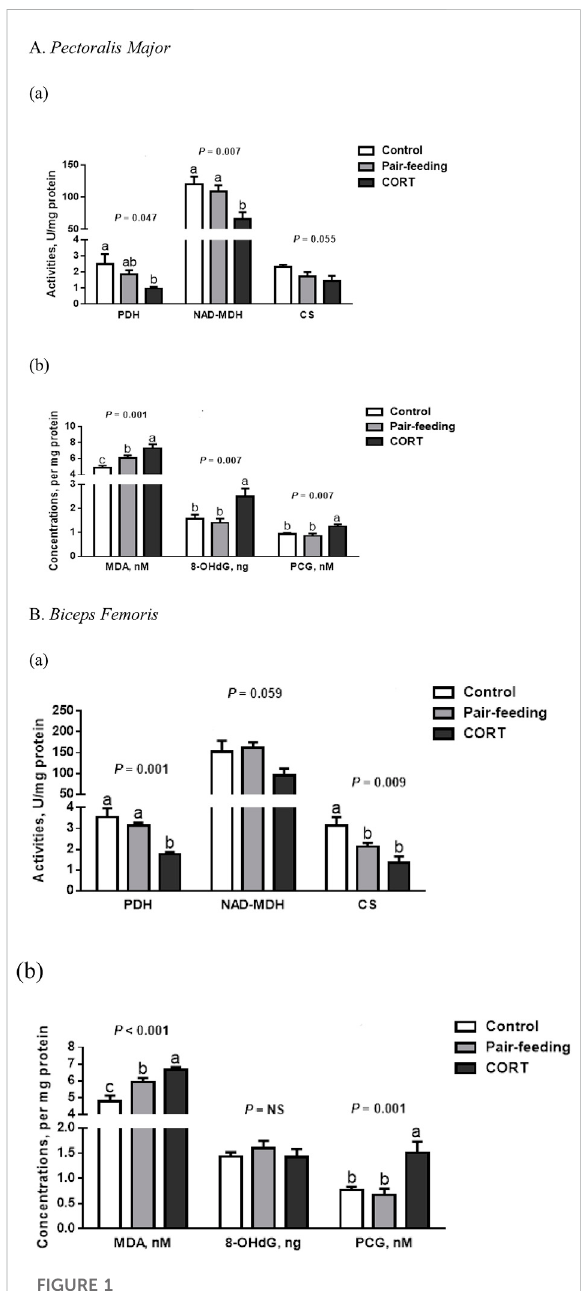
FIGURE 1 Activities of tricarboxylic acid cycle enzymes (a) and concentrations of oxidation products (b) in pectoralis major (A) and biceps femoris (B) muscles of broiler chickens treated with corticosterone(CORT,30 mg/kgdietfrom30to37 dofage). Data are means of 12 individuals of 2 birds per replicate. a-c Means without a common superscript differ ( p < 0.05). PDH, pyruvate dehydrogenase; NAD-MDH, NAD-dependent malate dehydrogenase; CS, citrate synthase; MDA, malondialdehyde; 8- OHdG, 8-hydroxy-2 ′ -deoxyguanosine; PCG, protein carbonyl groups; NS, p >